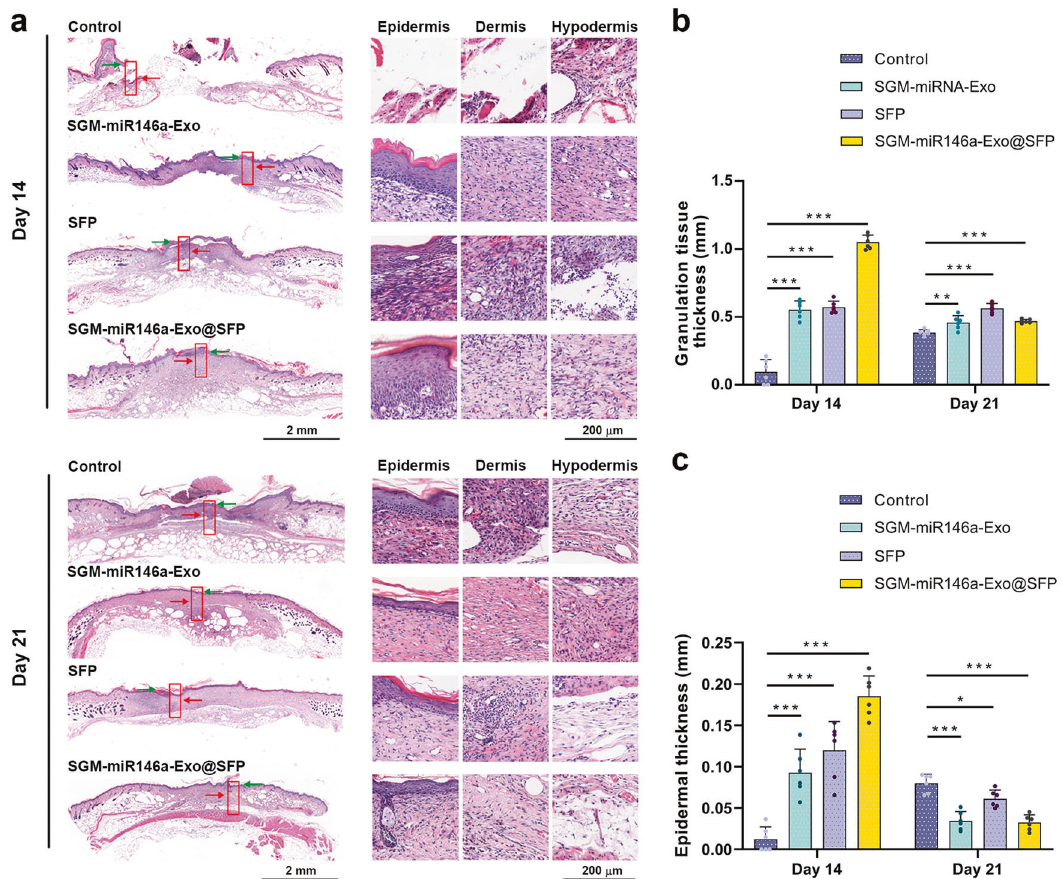
Fig. 6 Granulation tissue formation and re-epithelialization promoted by SGM-miR146-Exo@SFP. a Representative images of skin tissue section from the wounds on day 14 and day 21 stained by H&E (left, scale bar: 2 mm). High-magni fi cation images showed granulation tissue formation and epithelial tissue closure (right, scale bar: 200 μ m). Hair follicles and sebaceous glands could be observed in SGM-miR146a- Exo@SFP-treated wounds at day 21 (bottom right). The extent of epidermis and granulation tissue were marked with green arrows and red arrows respectively. b , c Statistical analysis of granulation tissue thickness and epidermal thickness in each group ( n = 6/group). Data represent the mean ± S.D. (* p < 0.05, ** p < 0.01, *** p <